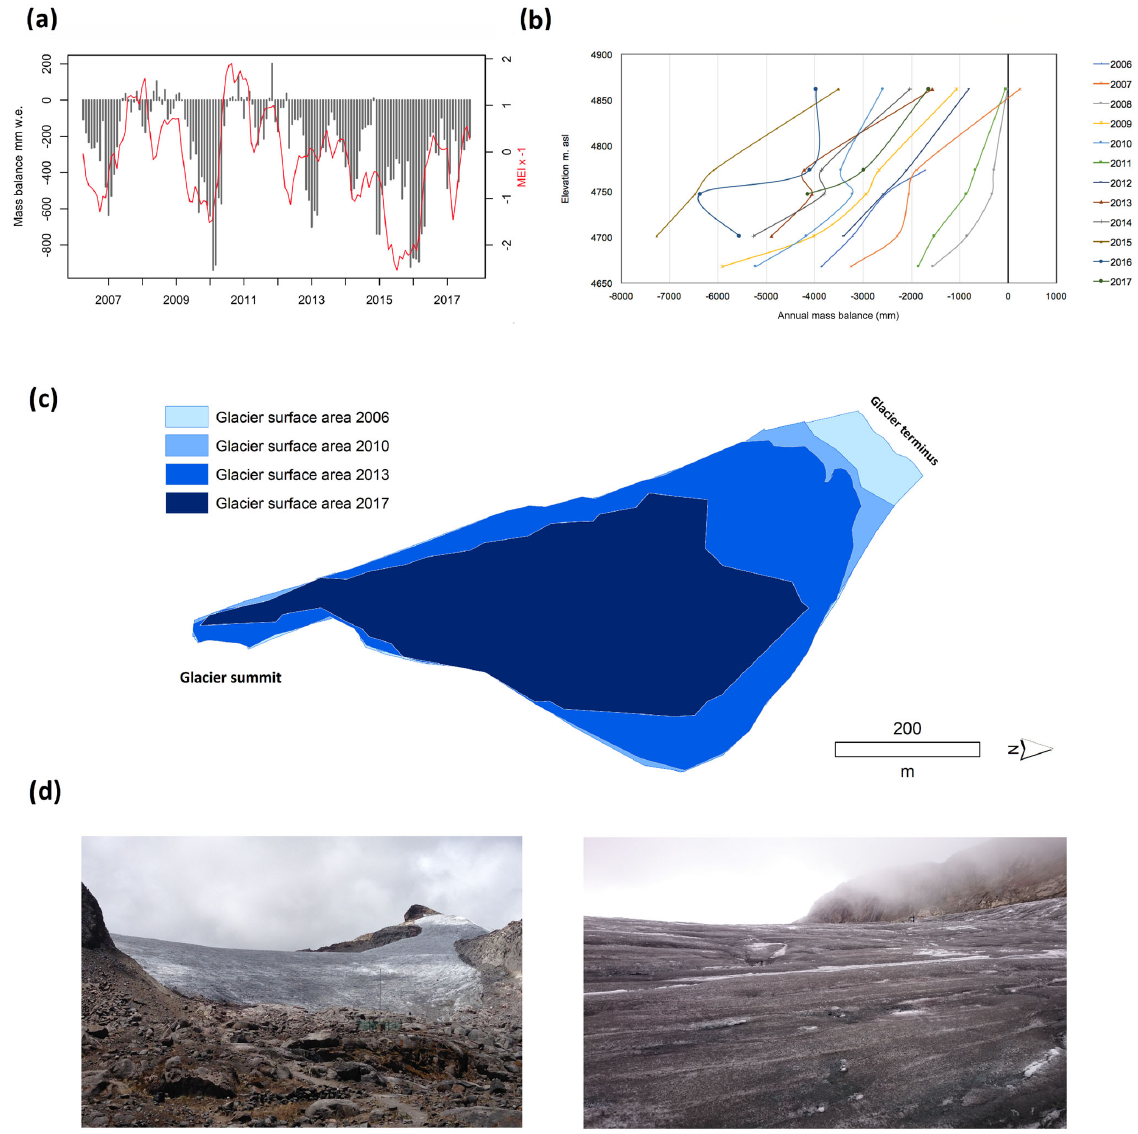
Figure 3. Evolution of the Conejeras glacier: (a) monthly mass balance (mm w.e.) and Multivariate ENSO Index (not the inverted axis); (b) annual mass balance per altitudinal range; (c) extension of the glacier in hectares in 2006, 2010, 2013 and 2017. (d) Photographs of the glacier surface covered by volcanic ashes, taken in 2015 and